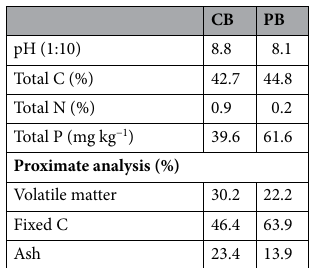
Table 2. Initial characteristics of corn residue (CB) and pine bark (PB)